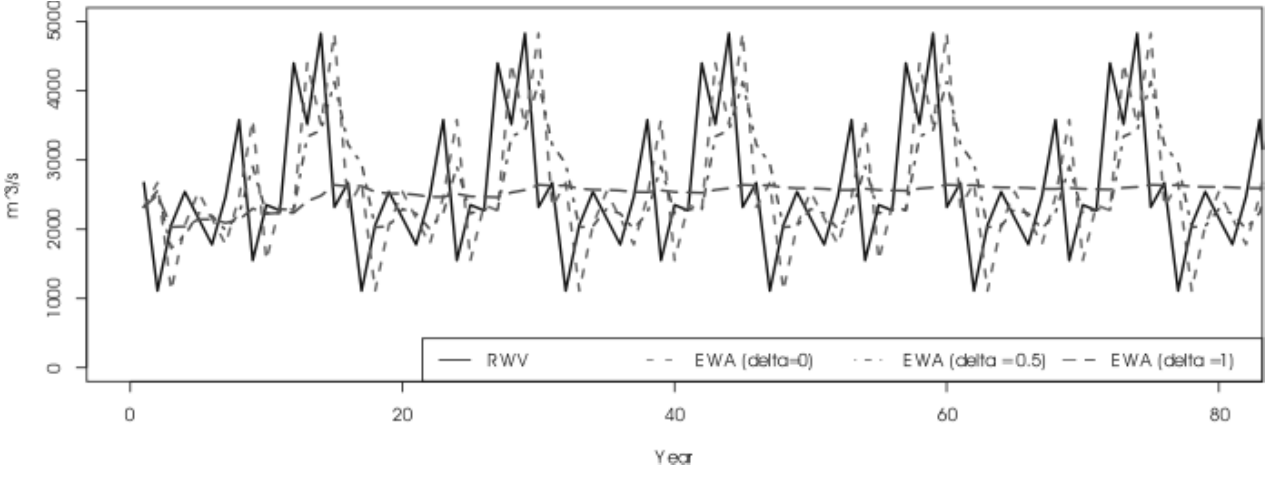
Fig. 4. Prediction of expected water availability with delta = 0, 0.5 and 1 compared to real water flows during the peak month, i.e., July of each